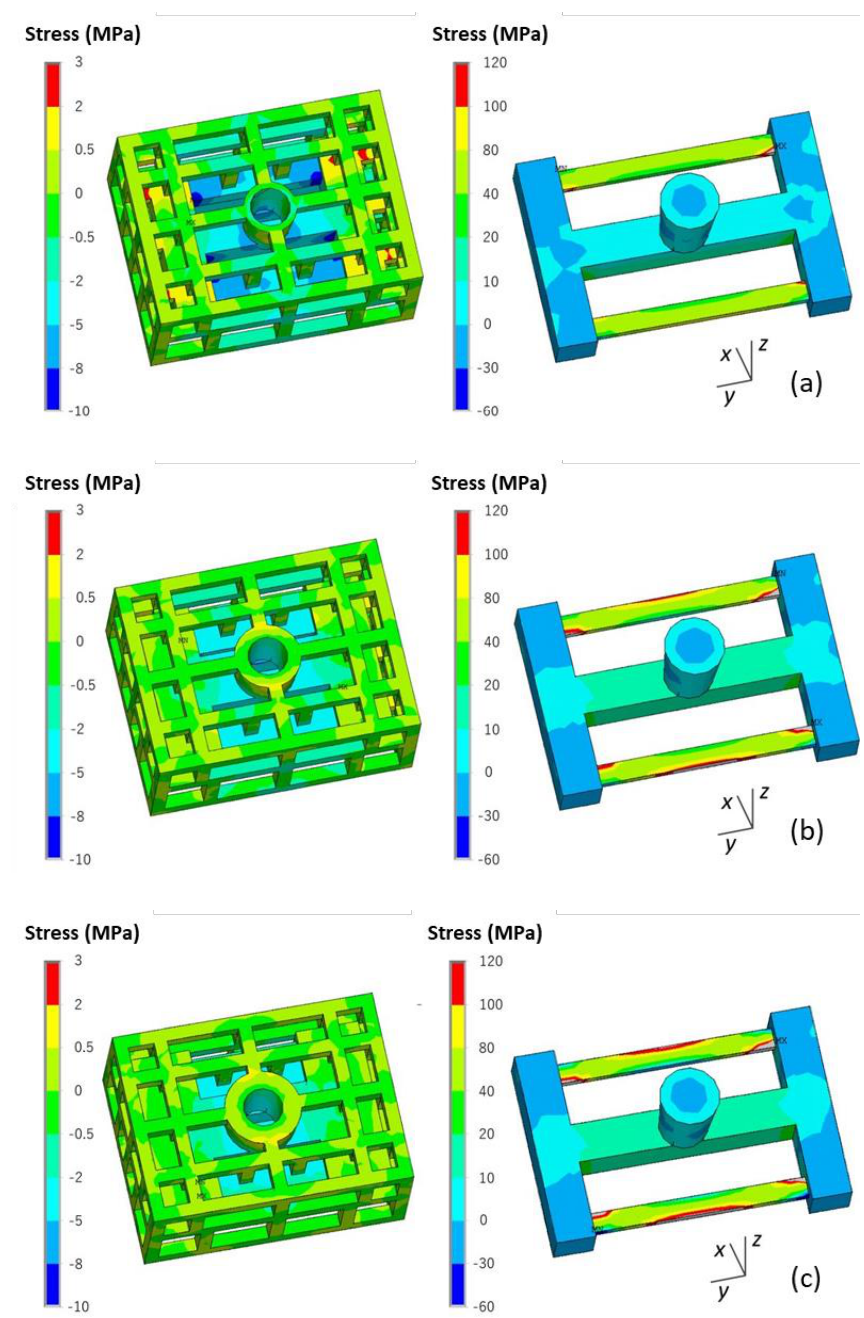
Figure 22. Comparison of the σ y stress of the skeletal sand molds and castings using a skeletal sand mold of different shell thickness: (a) 10 mm; (b) 20 mm and (c) 30 mm.